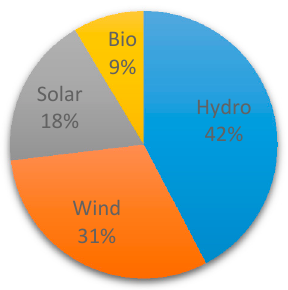
Figure 1. Renewable energy generation in Australia in 2016 [2].